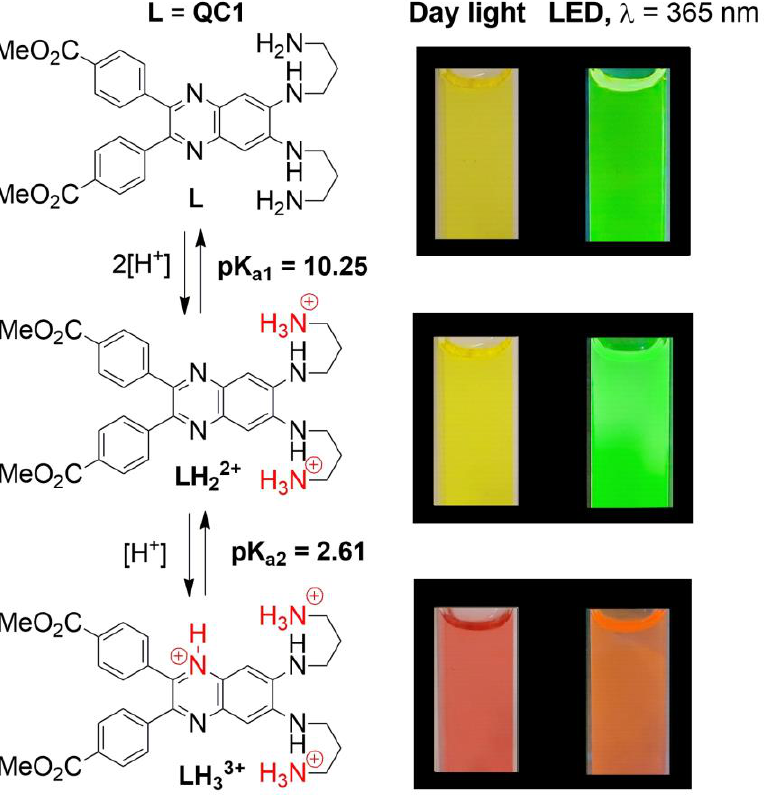
Figure 2. Protonation of QC1 and corresponding color changes observed in aqueous solution.